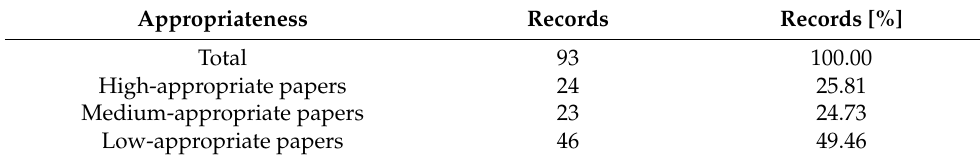
Table 1. Rating of the screened records.